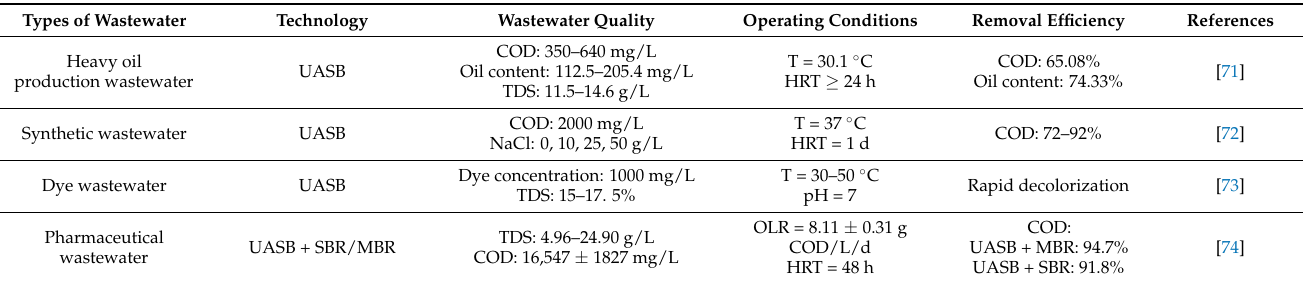
Table 8. Performance and experimental conditions of UASB for the treatment of saline